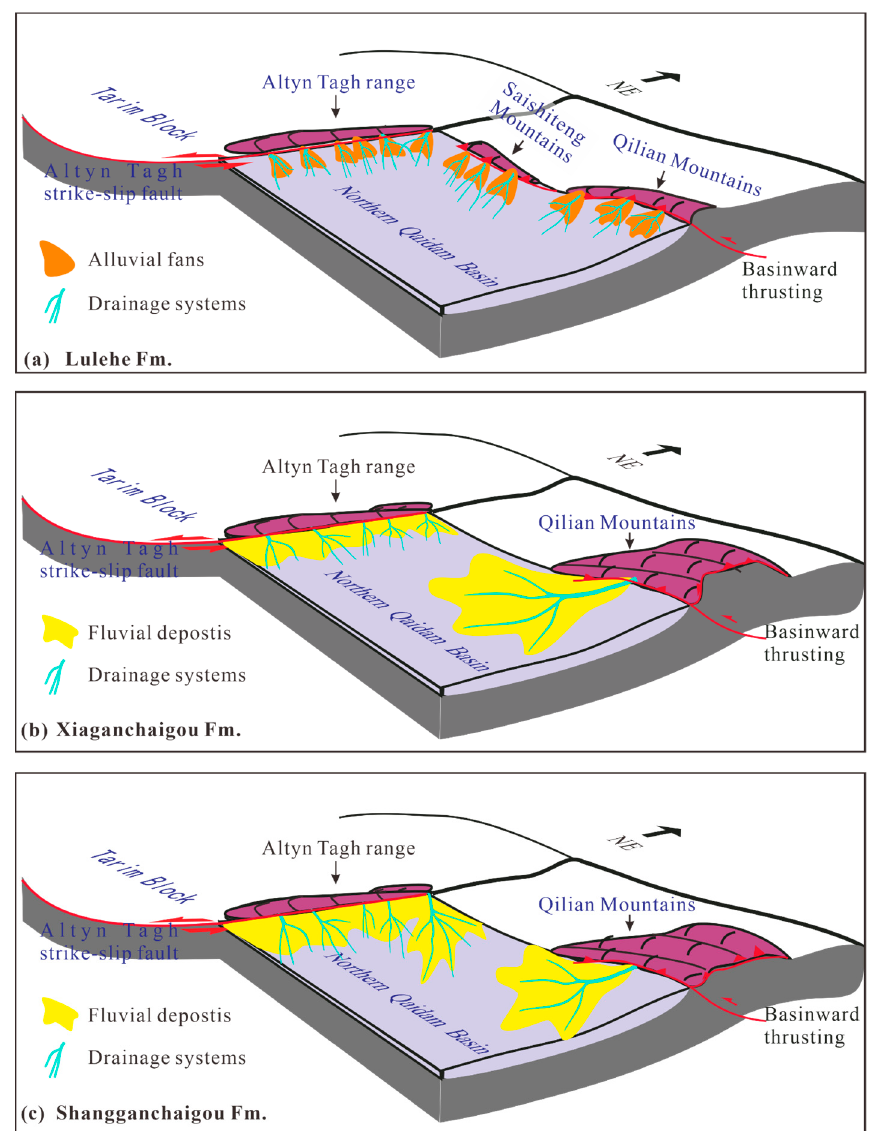
Figure 7. The paleogeographic maps of the Paleogene strata.